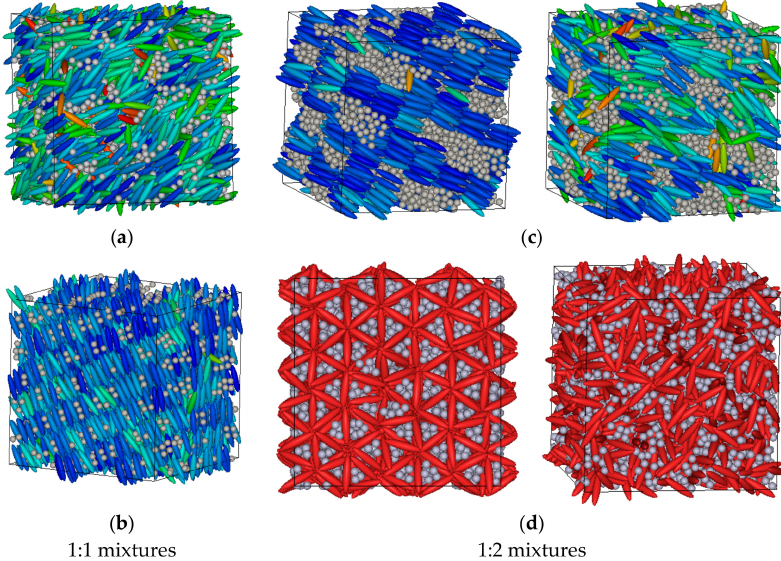
Figure 5. ( a ) 1:1 mixture: ionic nematic phase: q * = 0.50/ − 0.50, T * = 0.90; ( b ) 1:1 mixture: highly ordered crystal/smectic phase: q * = 2.00/ − 2.00, T * = 0.50. ( c ) 1:2 mixture: microphase segregated GB and LJ particles: q * = 0.50/ − 0.25, T * = 0.55 (left snapshot) and T * = 1.00 (right snapshot); ( d ) 1:2 mixture: microphase segregation GB and LJ particles: q * = 2.00/ − 1.00, T * = 0.50 (left snapshot) and T * = 0.55 (right snapshot), with GB particles arranged into an hexagonal structure hosting LJ particles inside the channels. We do not use colour-coding here since there is not a director of the phase. Packing fraction η * =